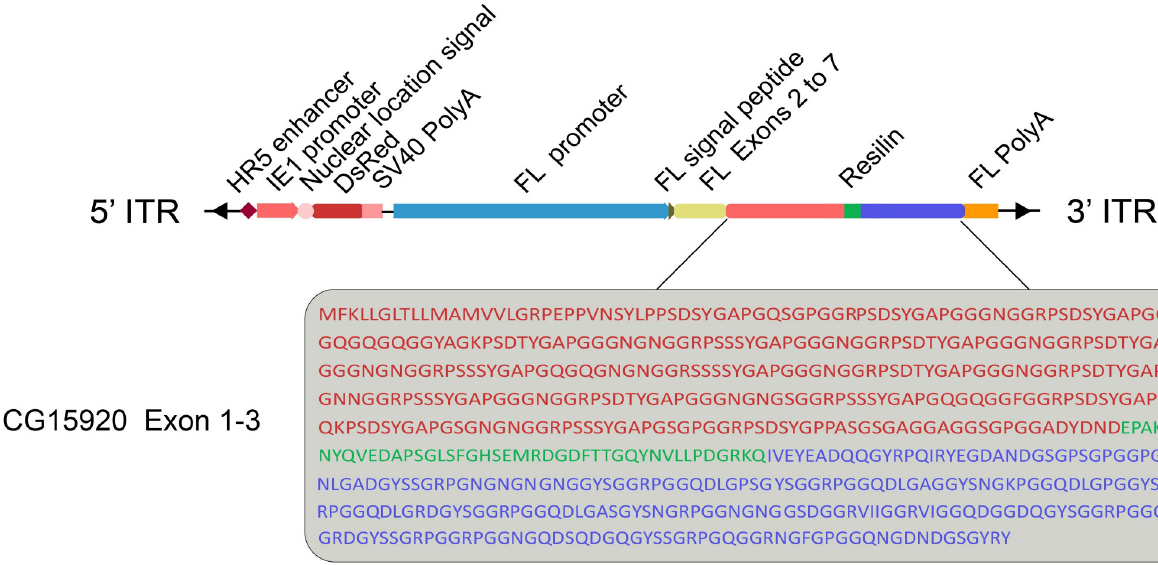
Fig 1. Schematic representation of resilin transgenic vector. 5’ITR and 3’ITR are the sequence of the left and right arms of the piggy Bac transposon plasmid. The IE1 promoter activates the systemic expression of DsRed as a marker for screening positive